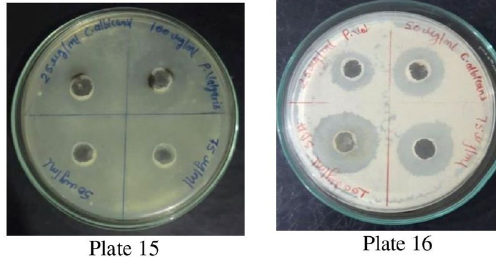
Fig. 11. Plate no. 13 & 14. Anti-Bacterial Activity ofMethanolic Extract P. vulgaris against A. niger.